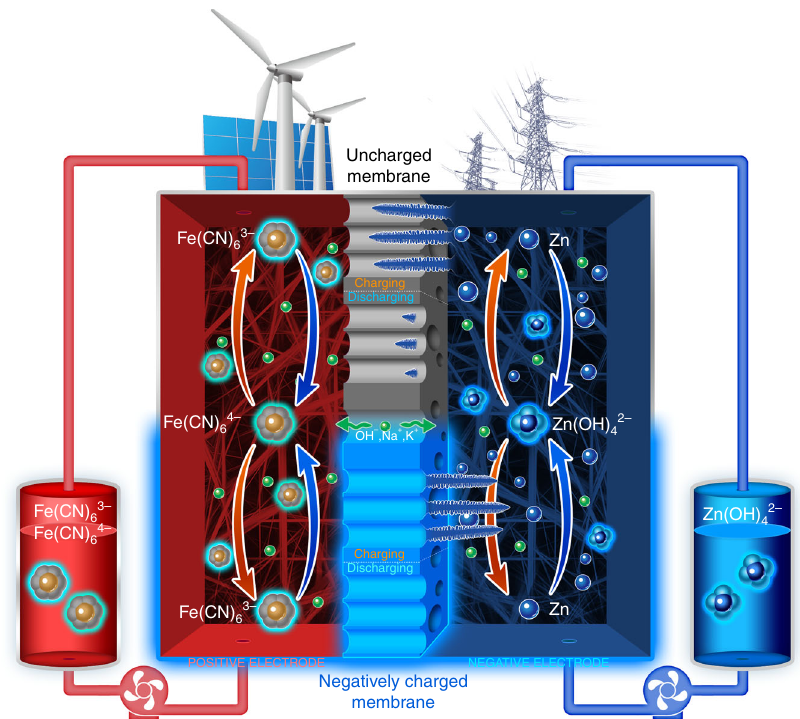
Fig. 1 Schematic of dendrite-free alkaline zinc – iron fl ow battery. The schematic represents the zinc dendrite/accumulation of the zinc – iron fl ow battery when employing an uncharged (top) and a negatively charged (bottom) nanoporous